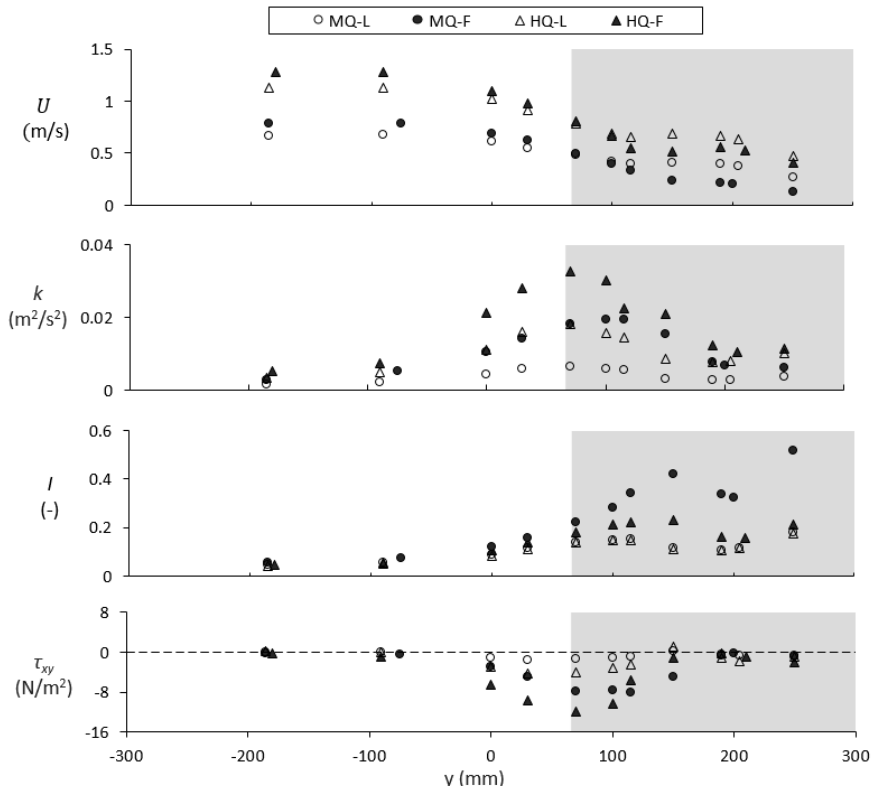
Figure 4. Lateral profiles of mean streamwise flow velocity U , turbulent kinetic energy k , turbulence intensity I , and lateral Reynolds stress τ xy at the relative depth of 0.6 h (z = 95 mm) in the fully developed flow region. The vegetated part is colored in grey. MQ = medium flow rate (50 L / s); HQ = high flow rate (83 L / s); L = leafless; F = foliated.